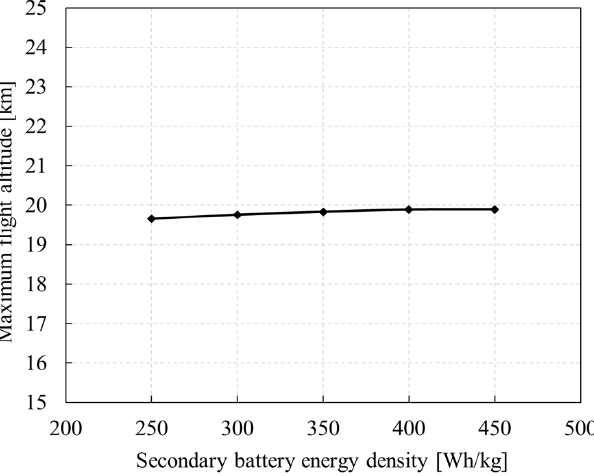
Figure 38. Variation of maximum flight altitude with secondary battery energy density .